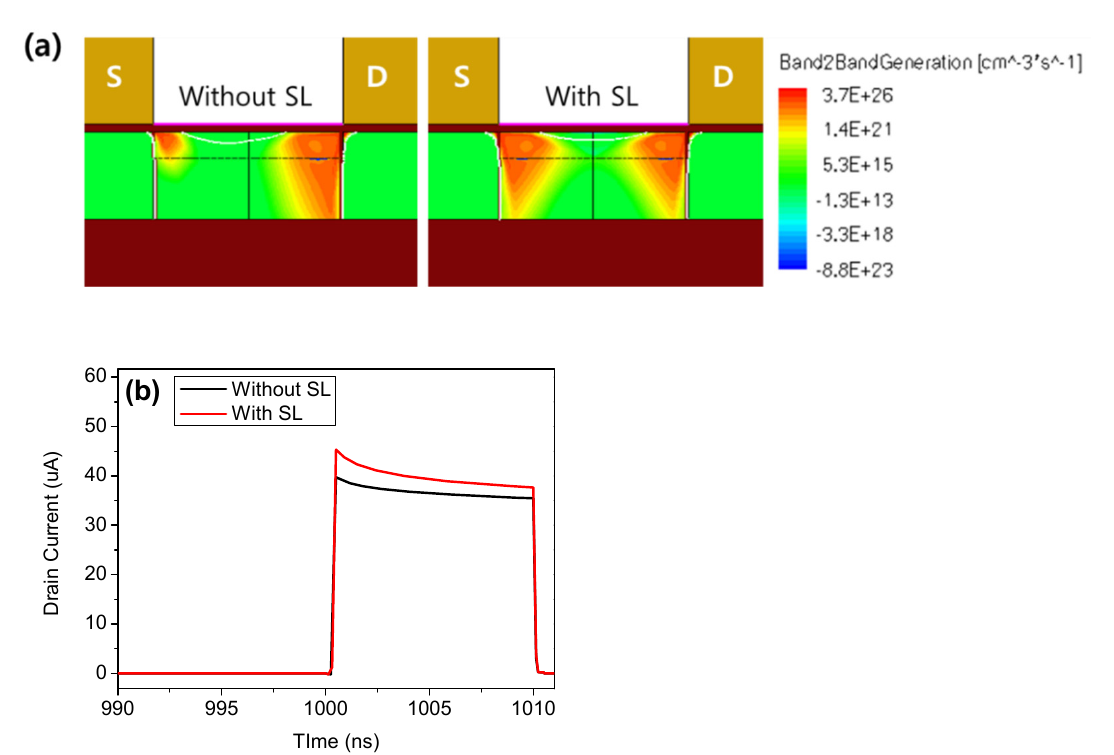
Figure 11. ( a ) BTBT generation contour of the proposed device with and without SL. ( b ) Difference in “1” current after one write “1” operation with and without SL.